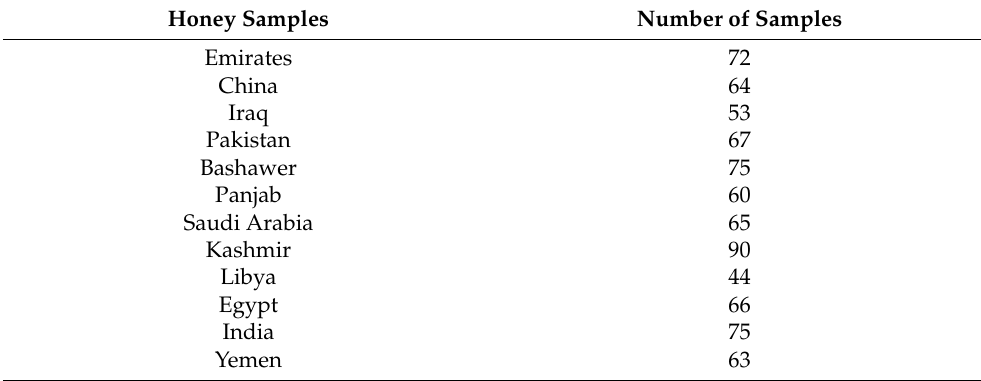
Table 1. Geographical origin of Sidr honey samples. Honey